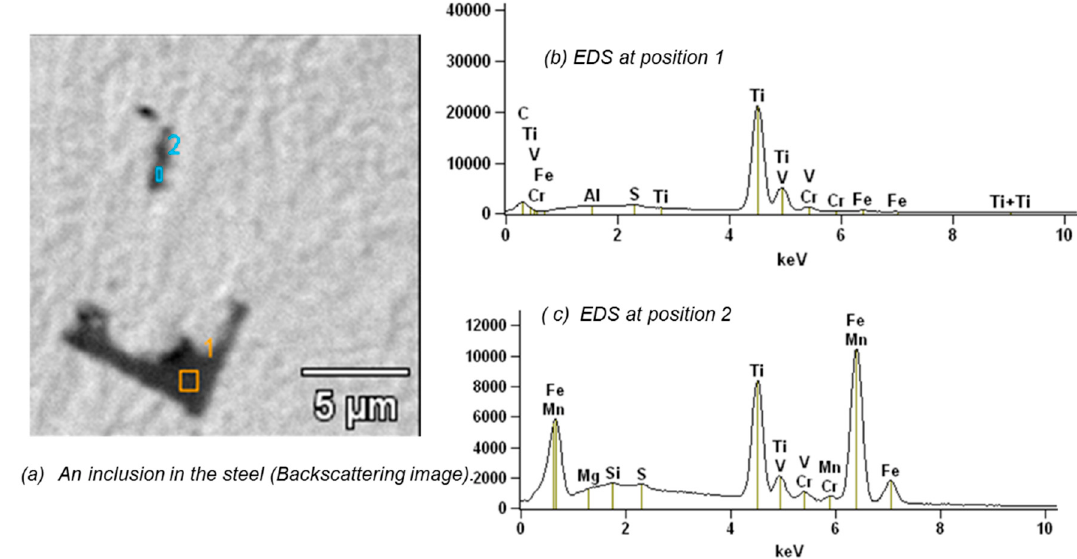
Figure 19. An inclusion (backscattering image ( a ), EDS plots in the position 1 ( b ) and at position 3